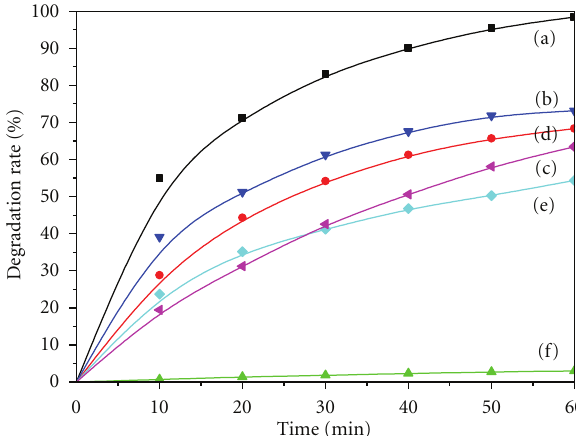
Figure 10: Degradation ratio of MO under ultraviolet light irradiation over catalysts as: (a) TiO 2 calcined at 500 ◦ C, (b) TiO 2 aged at 65 ◦ C for 90 h, (c) TiO 2 aged at 65 ◦ C for 120 h, (d) commercial P25, (e) TiO 2 aged at 65 ◦ C for 72 h, (f) blank.